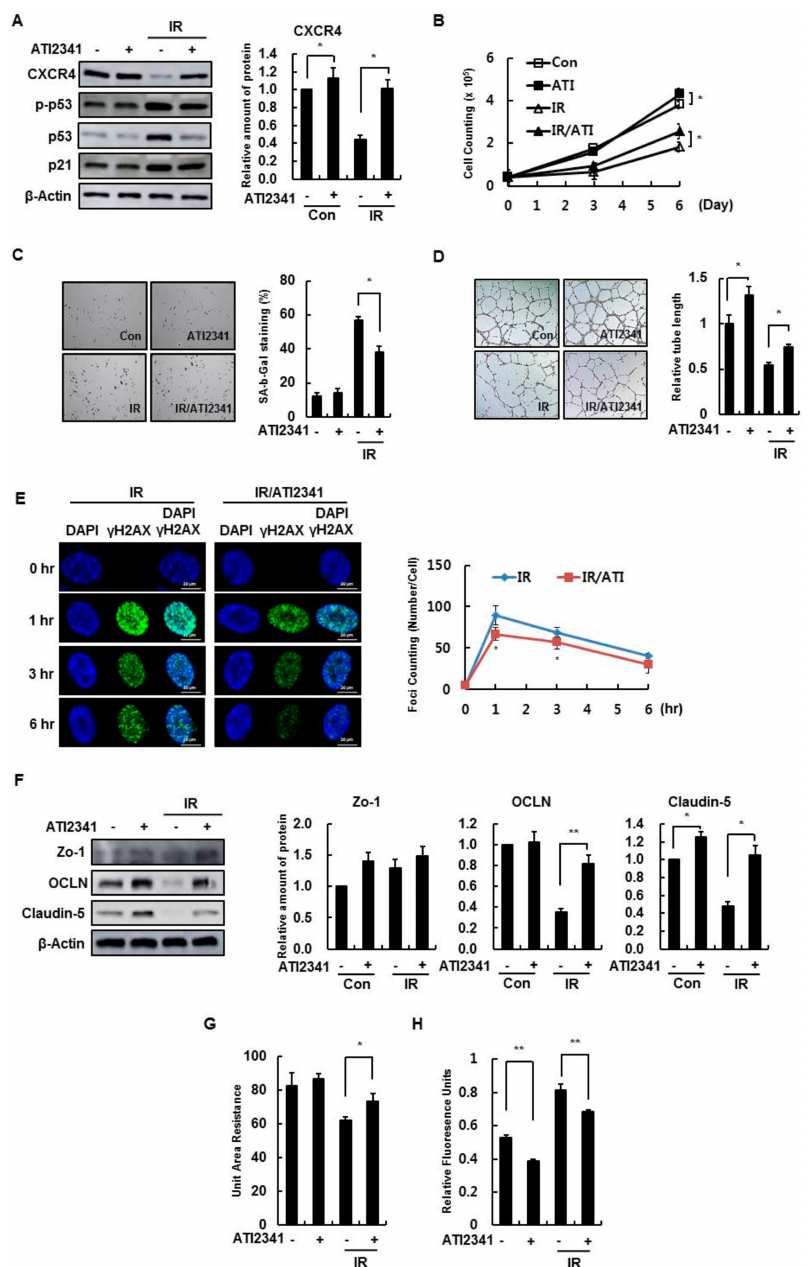
Figure 5. A CXCR4 agonist, ATI2341, enhances the cellular function of HBMVECs. ( A ) HBMVECs were irradiated (4 Gy) after 1 µ g / mL ATI2341 treatment and incubated for 24 h. Levels of CXCR4,